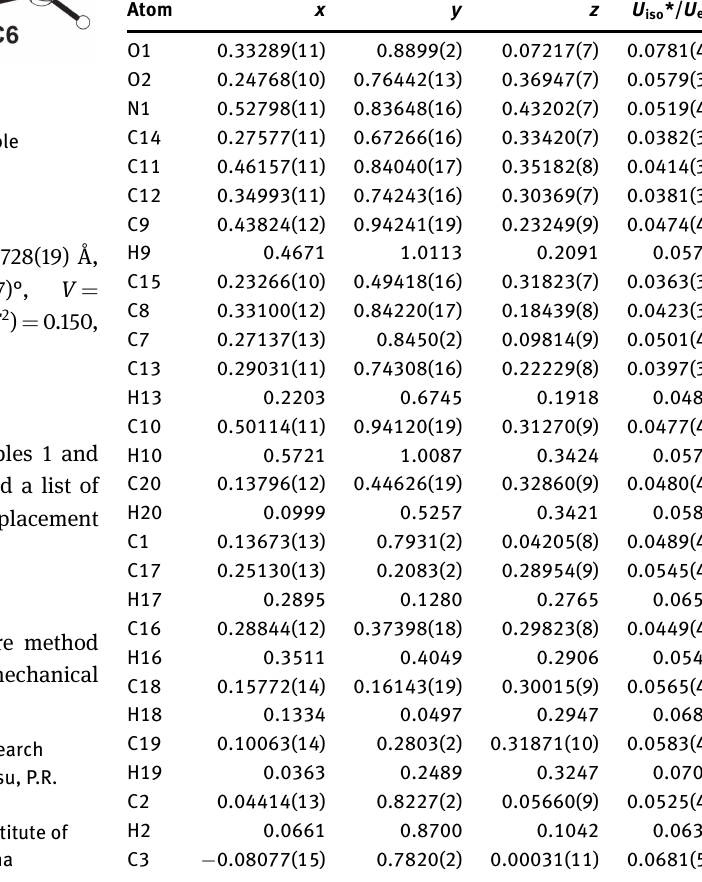
Table 2: Fractional atomic coordinates and isotropic or equivalent isotropic displacement parameters (Å 2